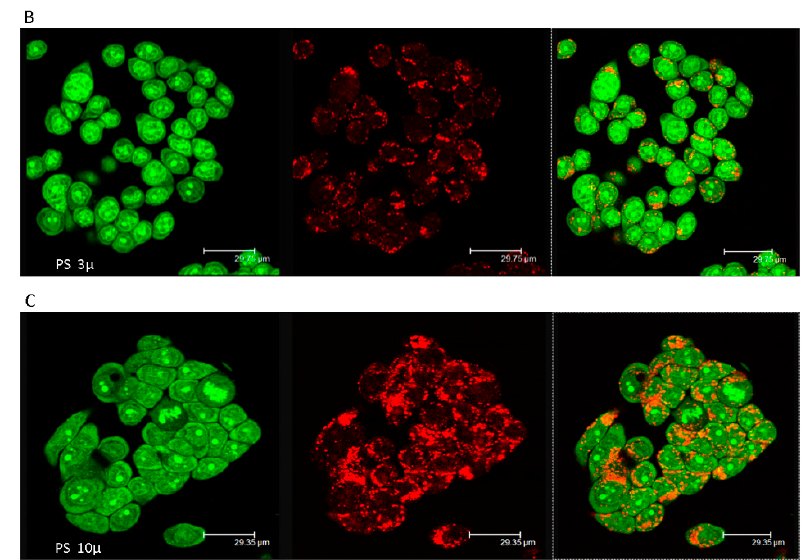
Figure 1. Membrane destabilization of the acidic vacuolar compartment in PS- MPs exposed cells.